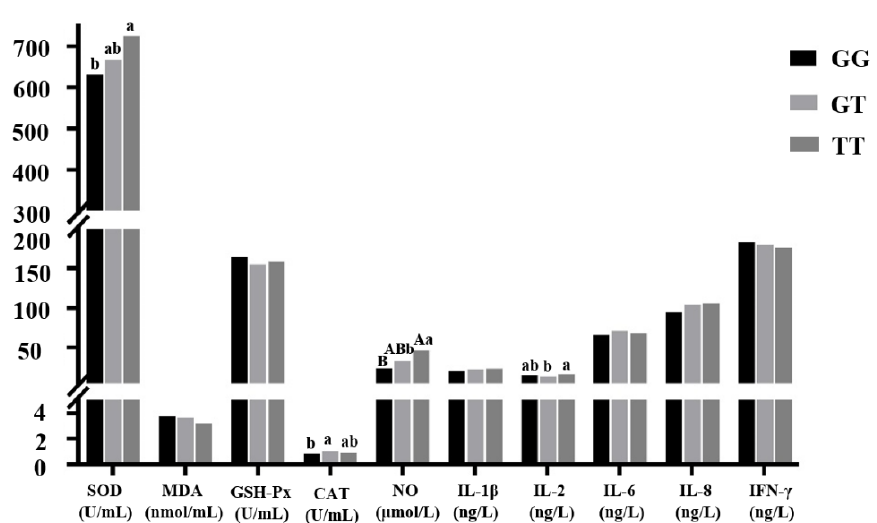
Figure 4. Correlation analysis between each genotype of the IL-8 gene G – 398T mutation and coccidiosis resistance indexes.